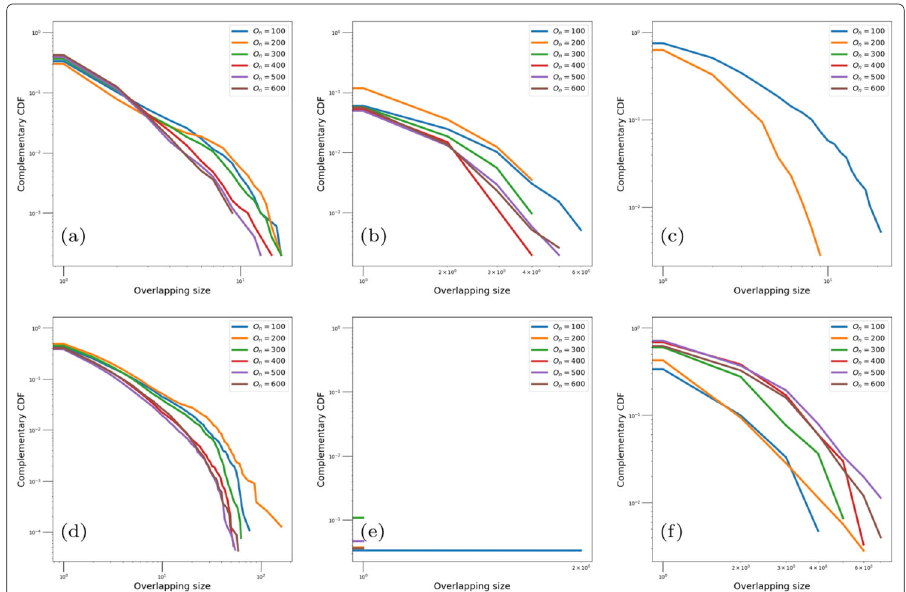
Fig. 19 Variation the number of nodes in the overlapping region ( O n ) for LFR synthetic networks considering the overlapping size: a Bigclam; b CFinder; c Copra; d Demon; e SLPA; f Ground-Truth